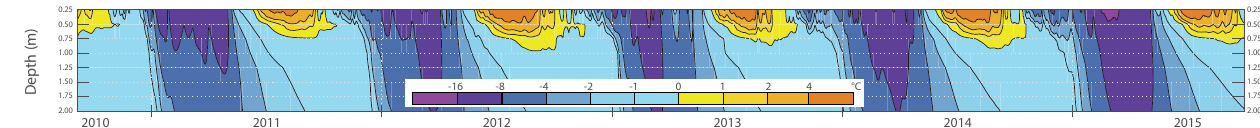
Figure 8. Temperature in the upper 2m of sediments during the period of September 2010 to December 2015. Contour values are shown in ◦ C, where yellow to orange gradients represent the active layer and blue gradients frozen